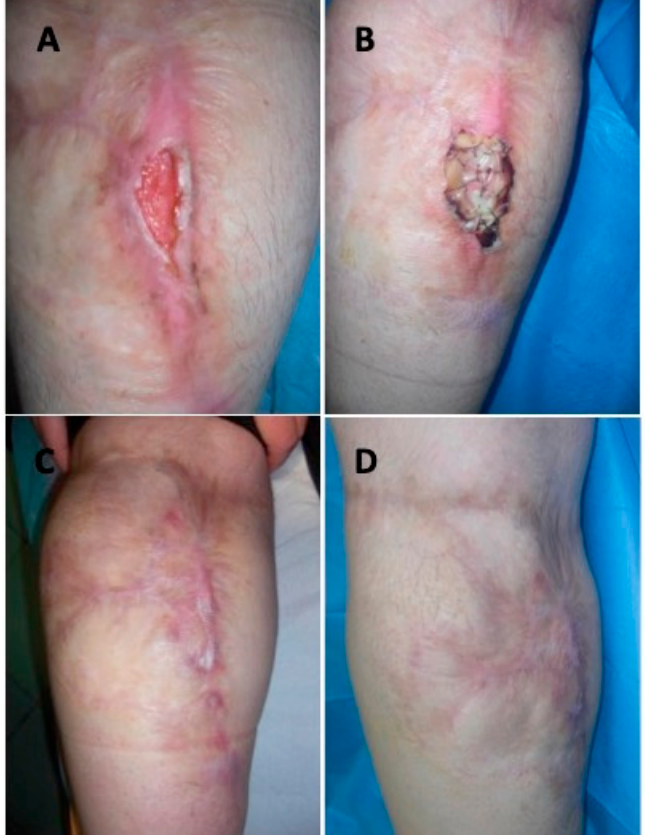
Figure 3. Clinical case. ( A ) Preoperative situation of patient affected by vascular ulcer of the back portion of the calf; ( B ) Follow-up period during DEG application; ( C ) postoperative situation showing healing 28 days after DEG; ( D ) post-operative situation one year after DEG.